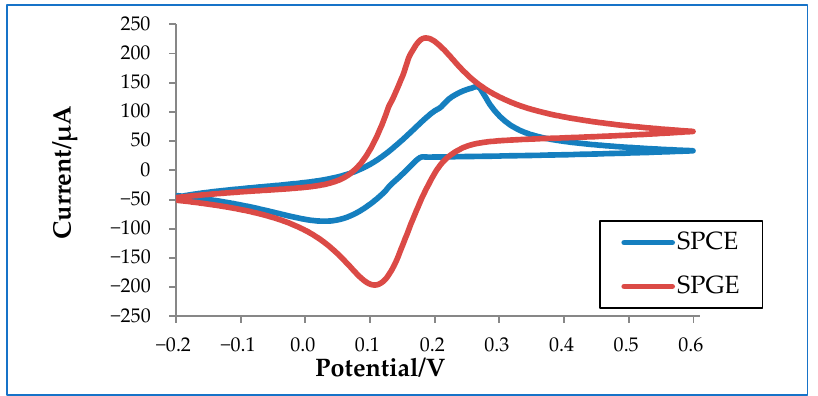
Figure 3. Cyclic voltammetry graph of a commercialized screen-printed carbon electrode (SPCE) and a screen-printed gold electrode (SPGE) in 10 mM ferrocyanide.